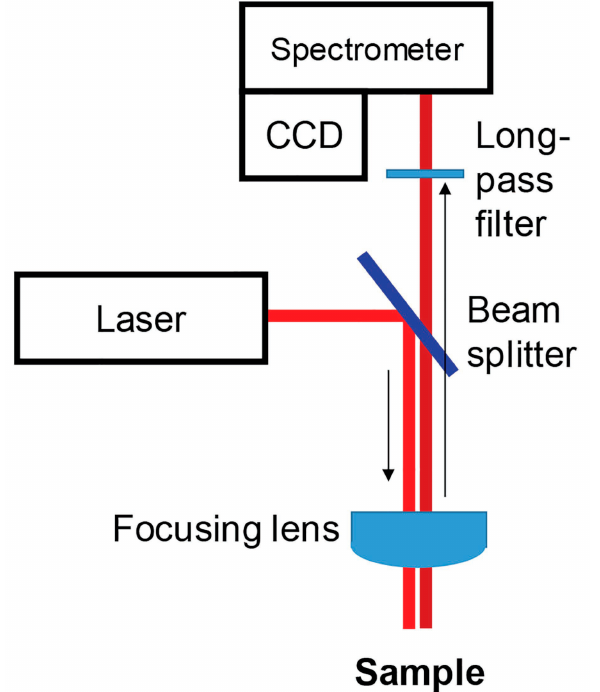
Figure 2. Schematic representation of a Raman spectrometer. Copyright Plant Methods